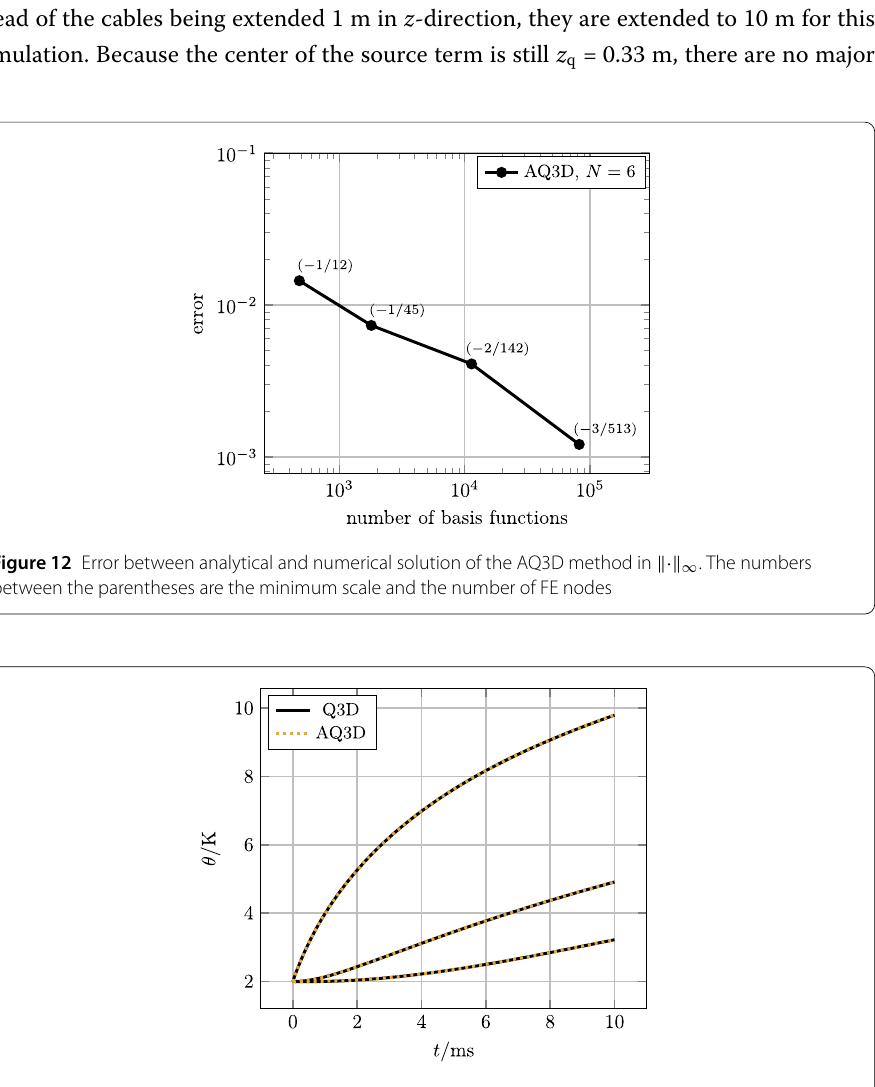
Figure 13 Evolution of the temperature in the three cables over time calculated with the Q3D and AQ3D method. Evaluated at z = z q and in the center of the cross-section of each